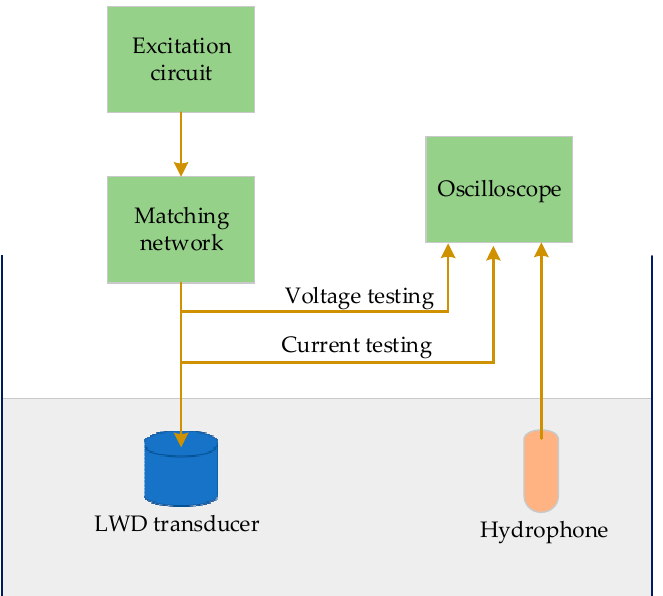
Figure 10. Schematic representation of the structure of impedance matching experiments. Table 1. The measured active power in the preset frequency band of the transducer before and after impedance matching. Frequency ( kHz )